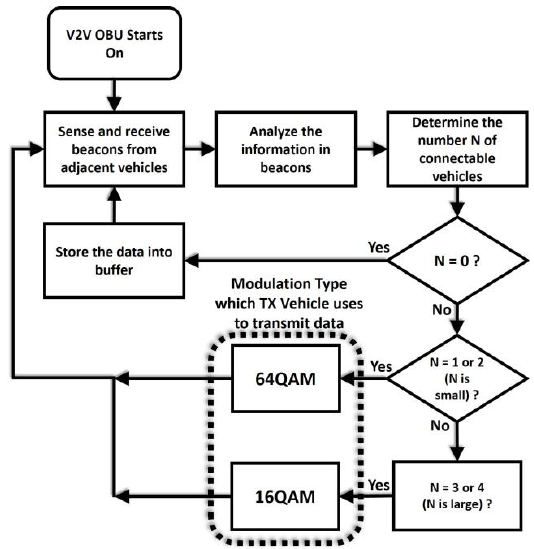
Figure 3. Flow chart for the proposed algorithm.